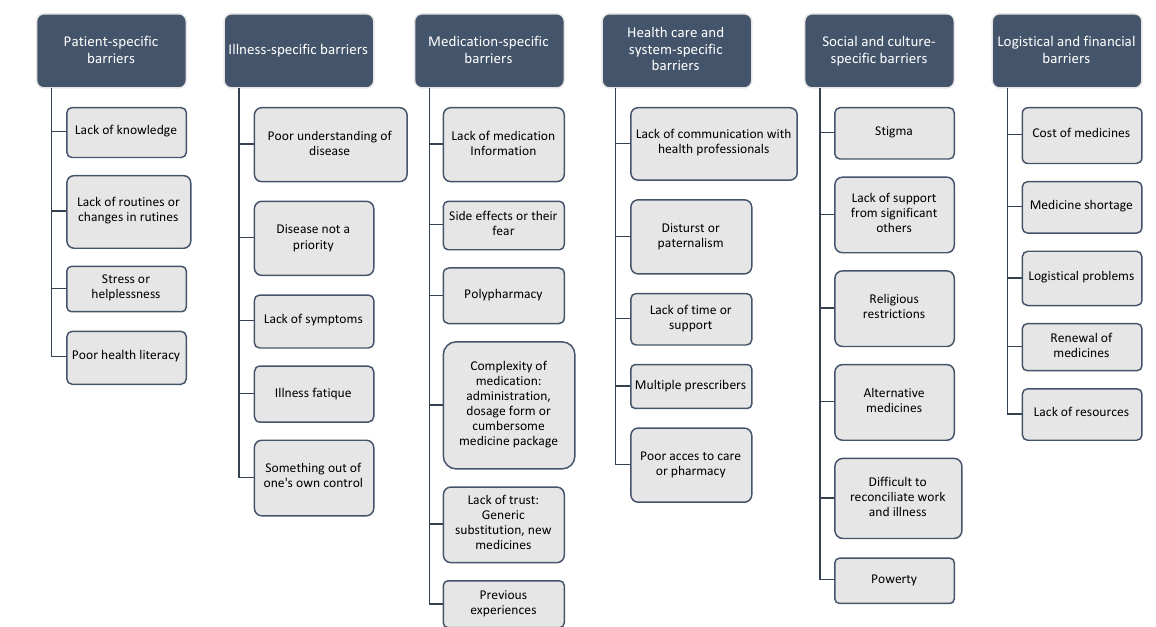
Figure 3. Subcategorisation of barriers to medication adherence arising from the included qualitative studies ( n =